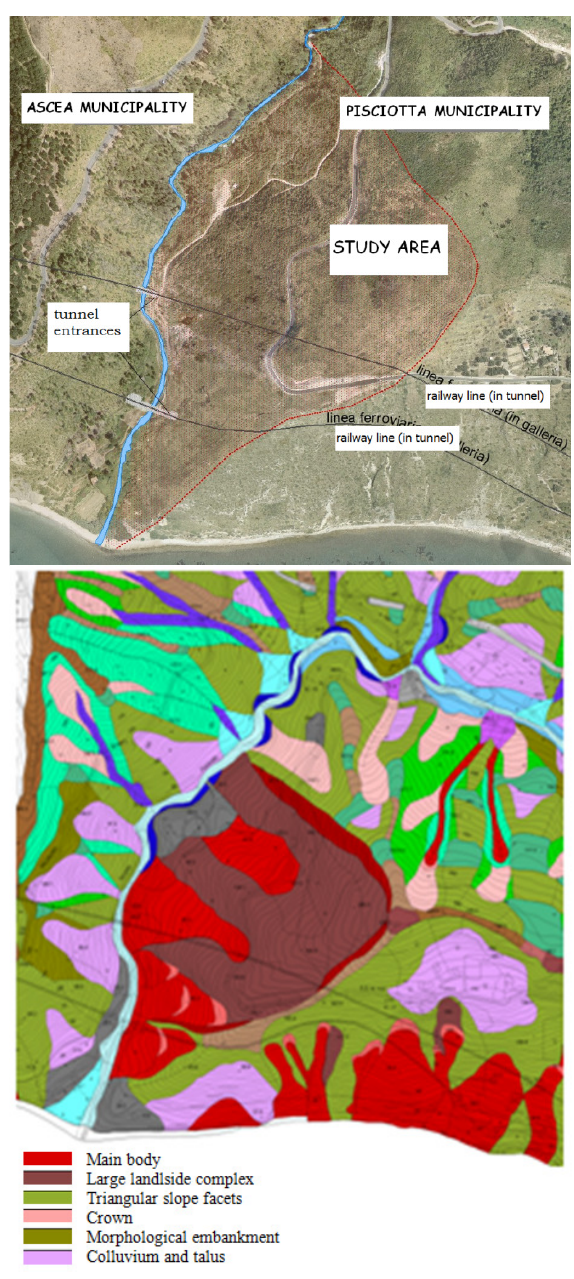
Figure 2. Location of landslide